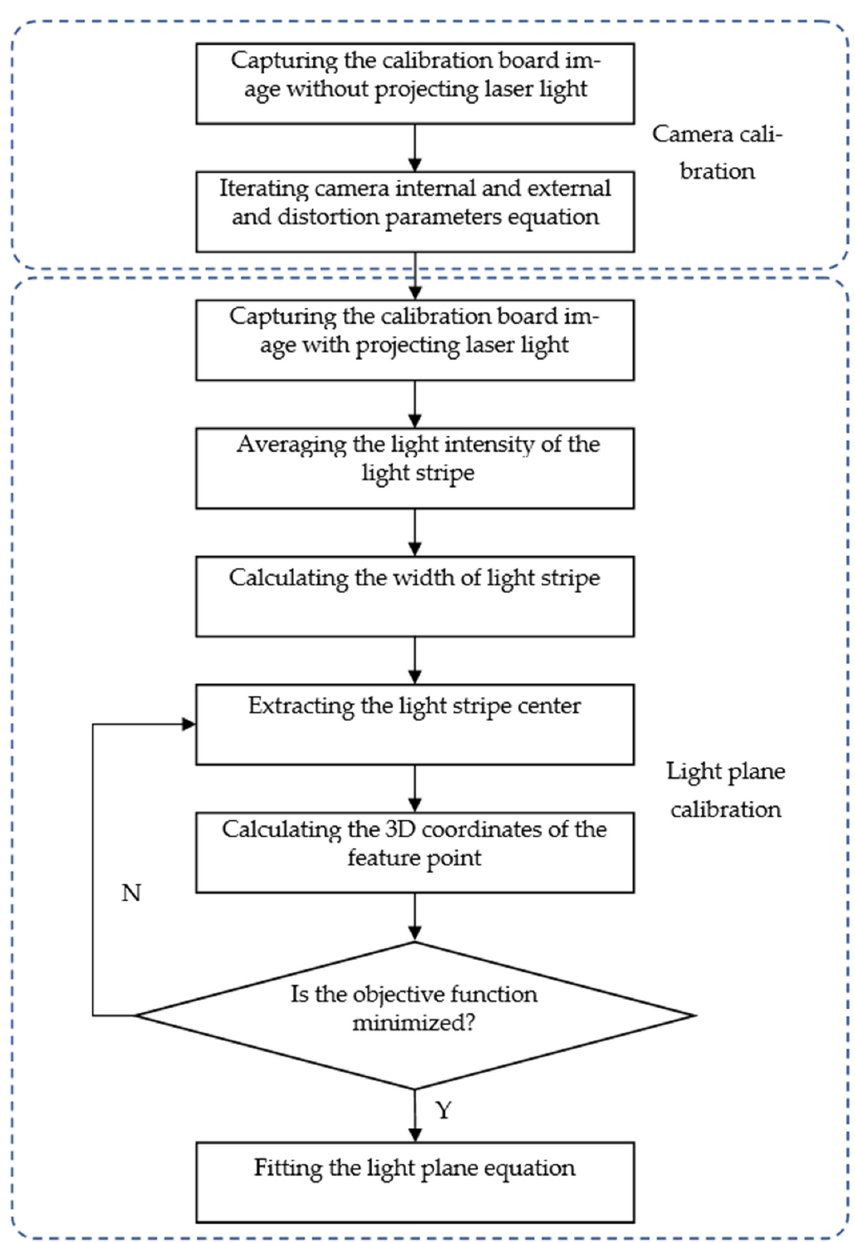
Figure 2. Calibration flow chart of line structured light system.